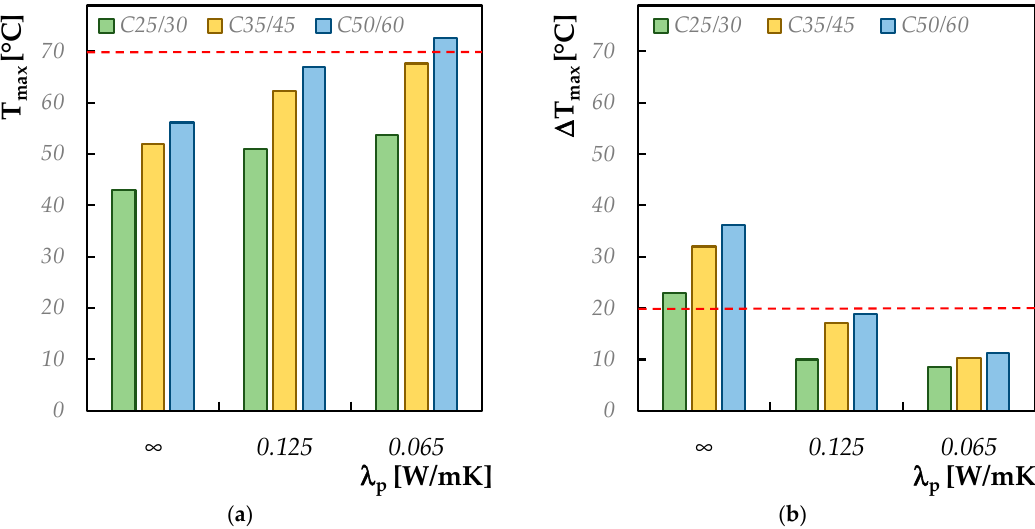
Figure 8. Maximum temperature ( a ) and maximum thermal gradient ( b ) by varying the formwork typology.